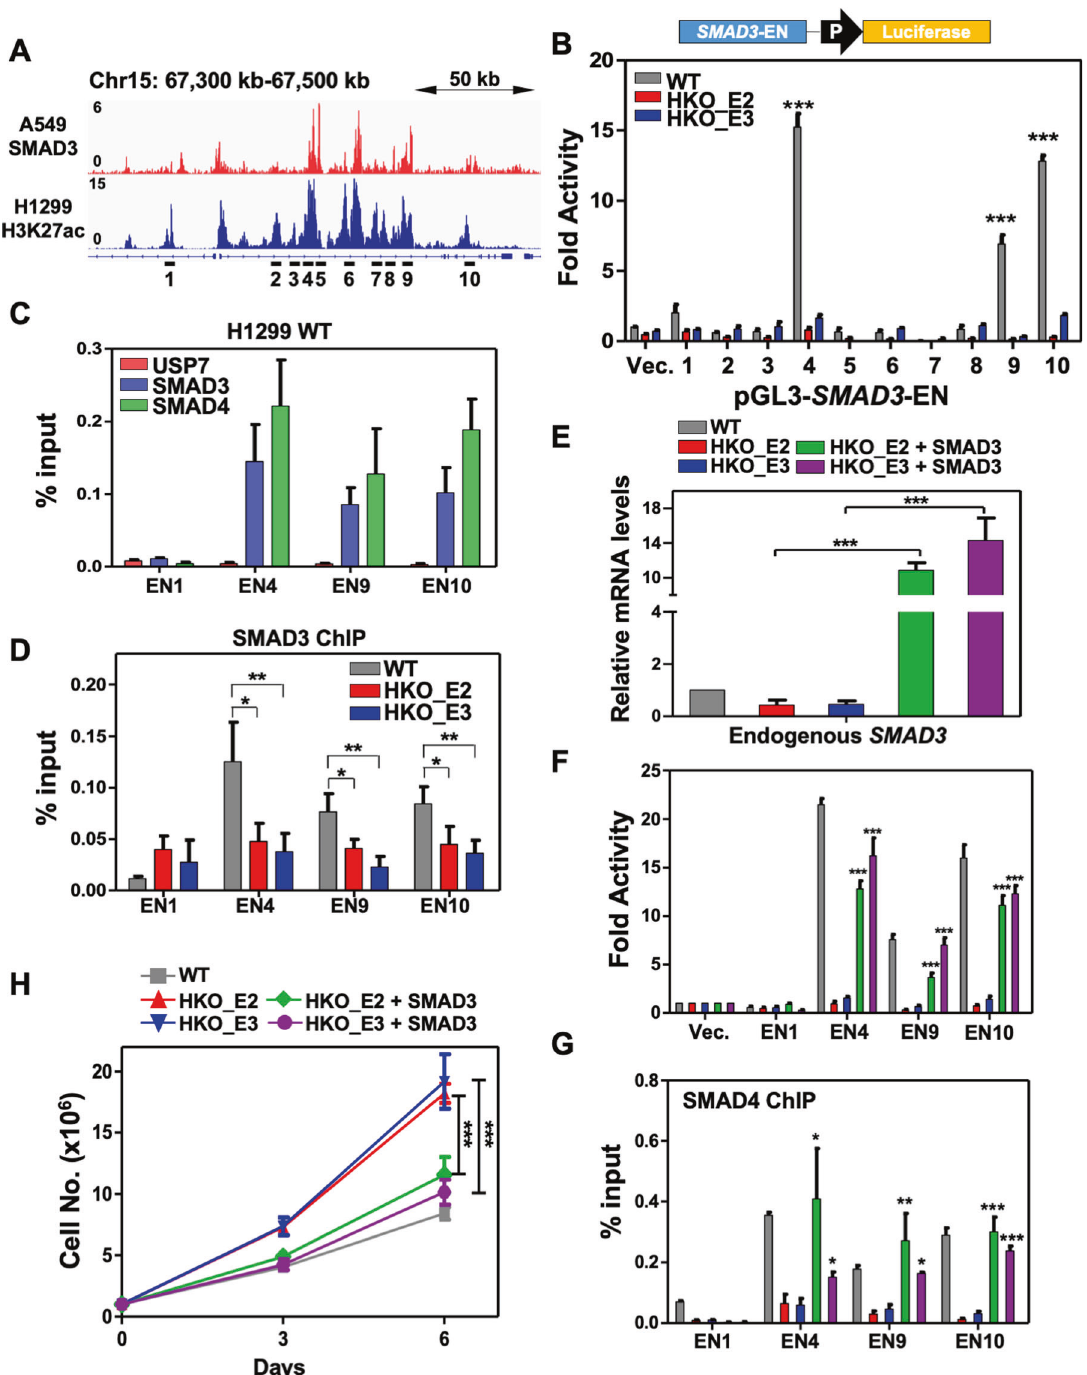
Fig. 4 USP7 is required for the positive autoregulation of SMAD3 . A IGV gene tracks at SMAD3 locus showing the ChIP-seq pro fi les of SMAD3 binding in A549 line (GSE51509) and H3K27ac occupancies in the H1299 line. The constituent enhancers within the identi fi ed SE domains are numbered and denoted at the bottom. B Luciferase reporter assays showing the relative enhancer activities of the SMAD3 SE constituents driven the expression of a mini-SV40 promoter-reporter (upper) in H1299 wildtype (WT) and USP7 KO cell lines. Fold activities relative to pGL3 -promoter (Vec.) are shown as means ± SD, triplicated experiments. C ChIP-qPCR assays showing the binding of USP7, SMAD3, and SMAD4 at indicated SMAD3 SE constituents in H1299 wildtype (WT) cells. Note, the detection of USP7 binding at these regions was failed. D ChIP-qPCR assays showing the binding of SMAD3 at indicated SMAD3 SE constituents, as described in ( B ), in H1299 wildtype or USP7 KO cell lines. E RT-qPCR assays showing the relative expression levels of endogenous SMAD3 in H1299 wildtype (WT) and USP7 KO cells without or with ectopically expressed SMAD3. Same cell treatments were used for panels E to G . F Luciferase reporter assays showing the relative enhancer activities of indicated SMAD3 SE constituents in indicated cell treatments. G ChIP-qPCR assays showing the binding of SMAD4 at indicated SMAD3 SE constituents in indicated cell treatments. H Cell proliferation assays showing the growth of H1299 wildtype or USP7 KO cells without or with ectopically expressed SMAD3. Throughout the fi gure, mean ± SD from three independent experiments. Student ’ s t -test, * p < .05; ** p < .01; *** p <